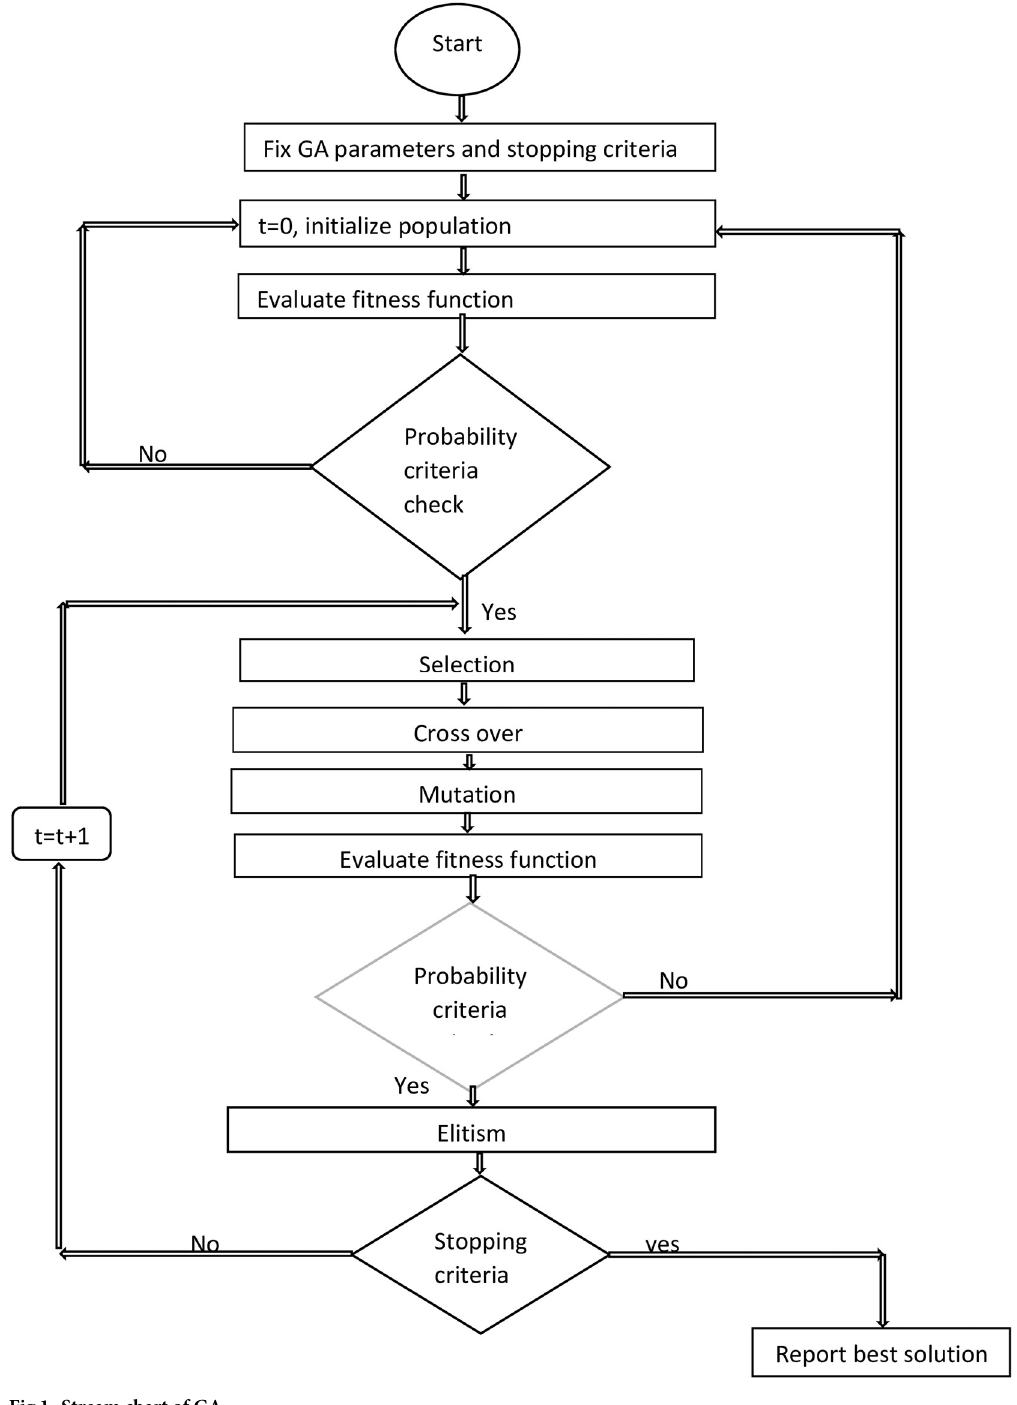
Fig 1. Stream chart of